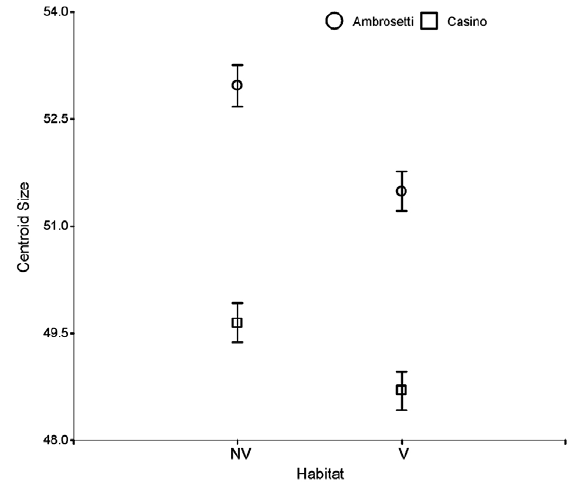
Fig. 3. – Mean and standard error of shell size (centroid size) of the scorched mussel Perumytilus purpuratus sampled from vegetated (V) and non-vegetated (NV) patches in two rocky salt-marshes.